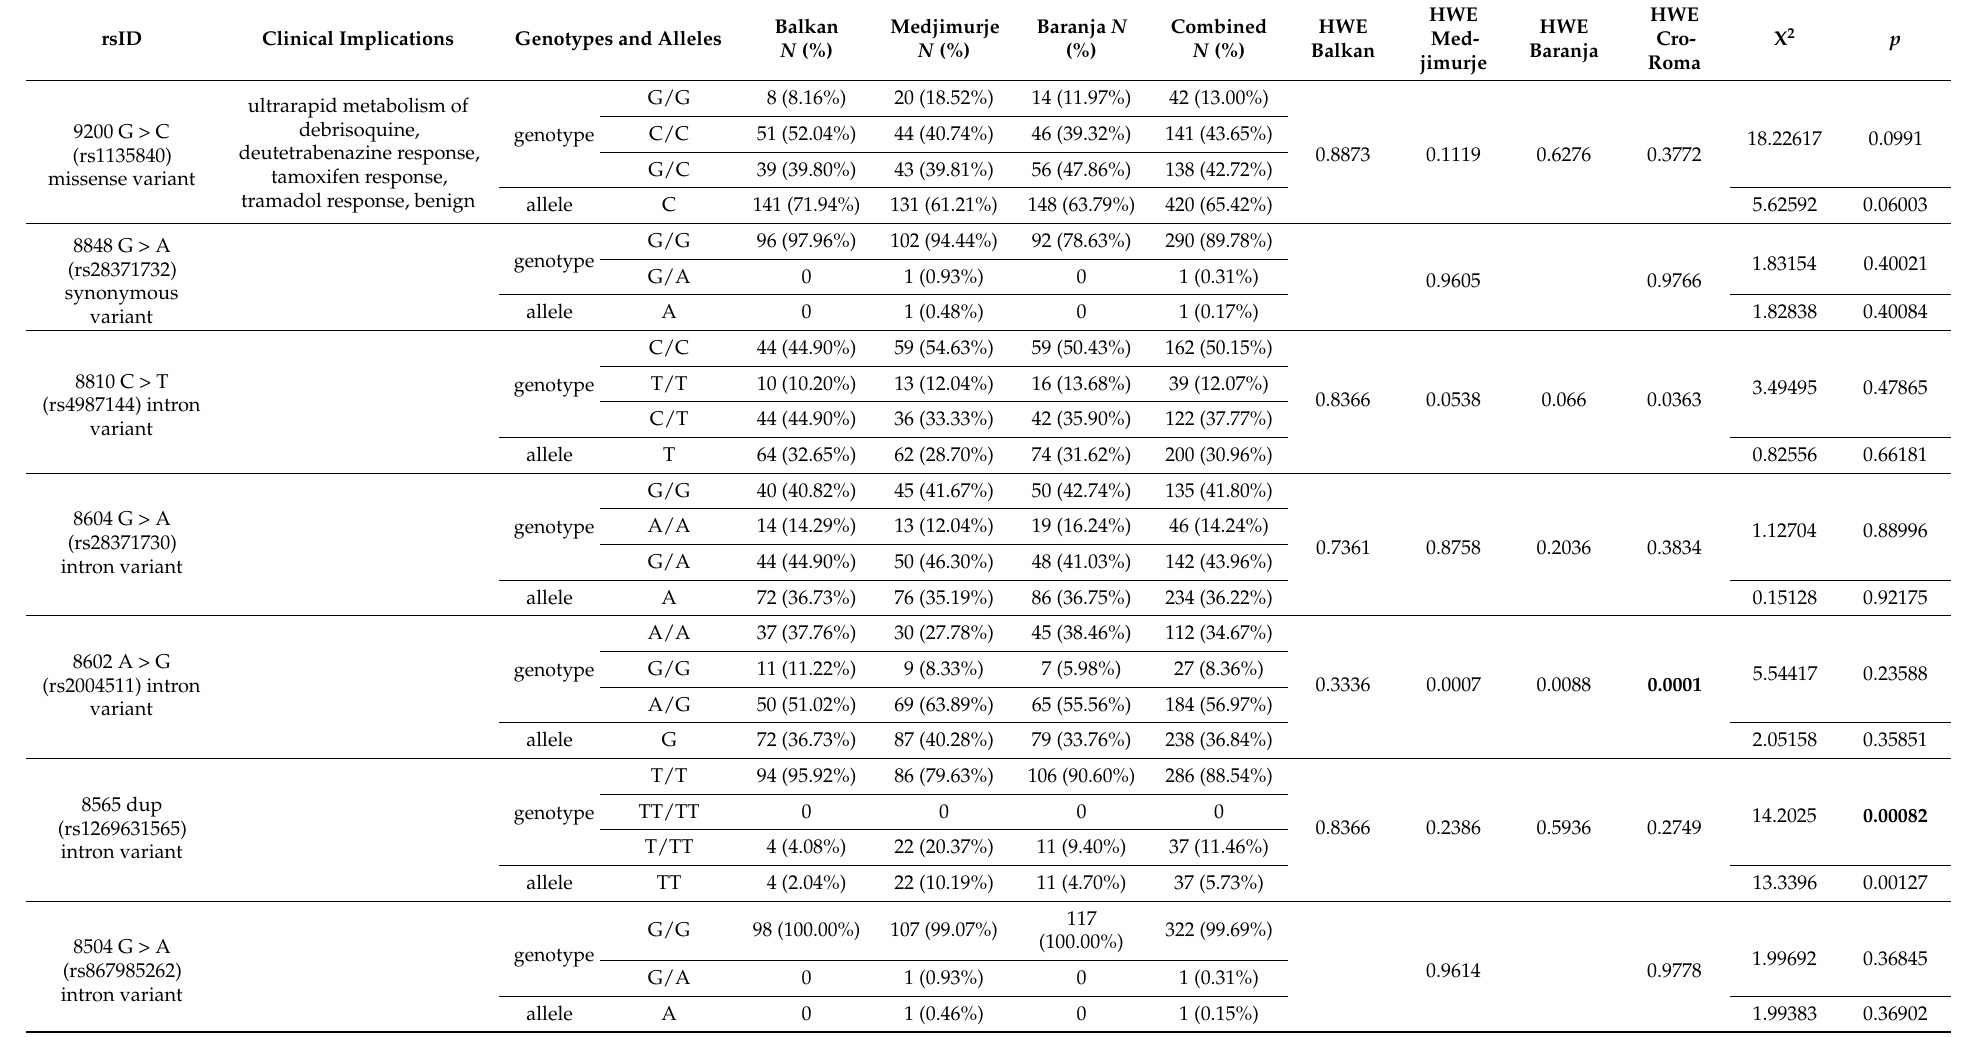
Table 1. Genotype and allele frequencies of CYP2D6 polymorphisms in the three Croatian Roma samples (Balkan, Medjimurje, Baranja) and in the combined